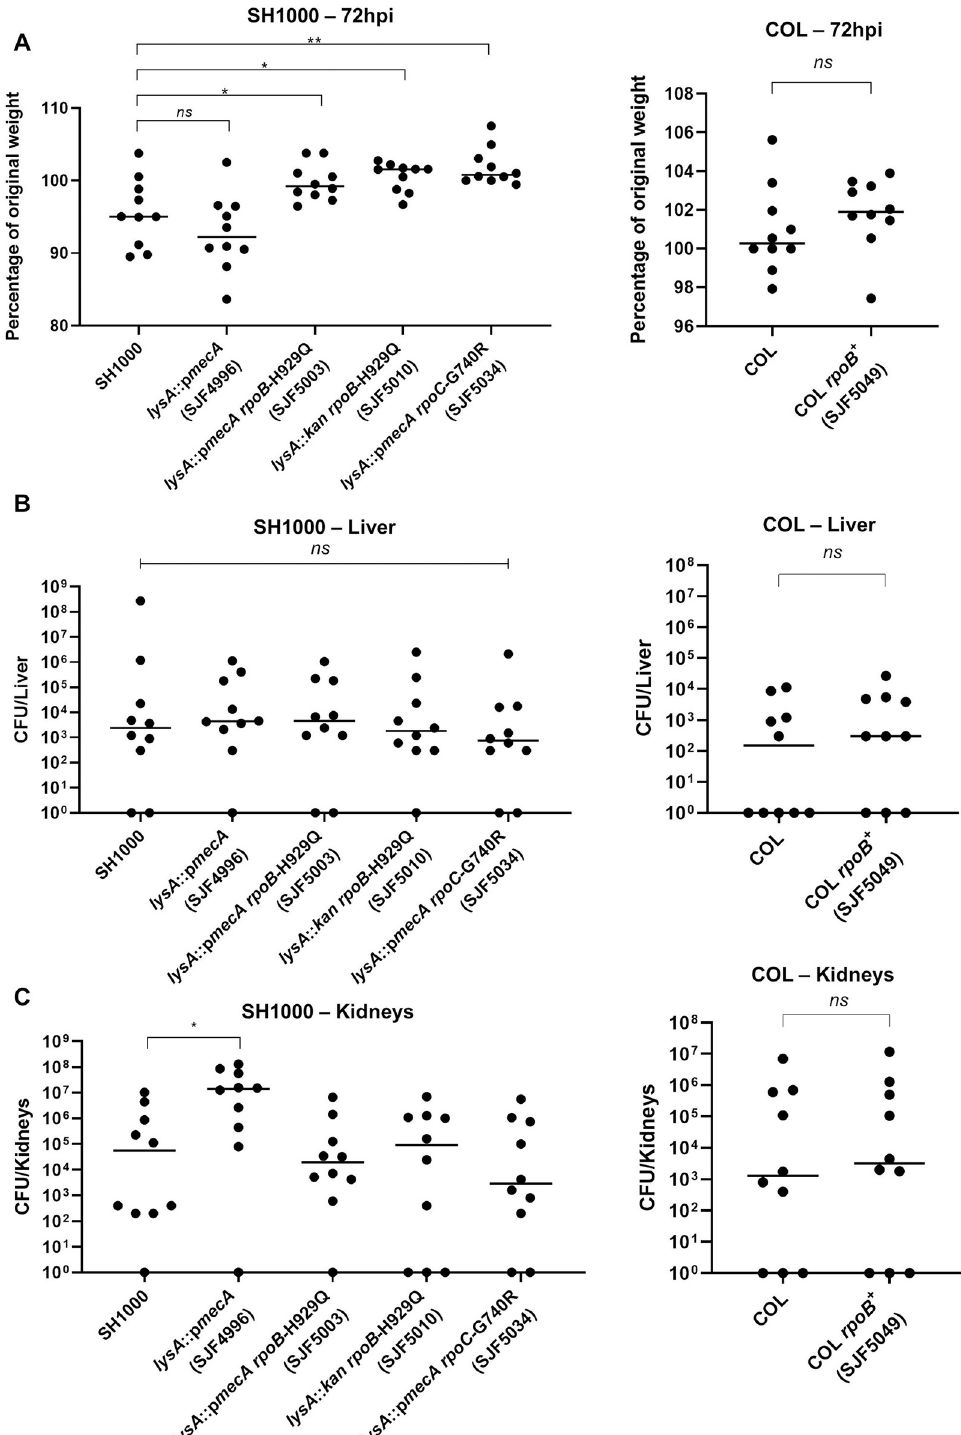
Fig 9. Virulence of S . aureus strains in a murine sepsis model. Mice were injected with 1 x 10 7 CFU per mouse with SH1000, lysA ::p mecA (SJF4996), lysA ::p mecA rpoB -H929Q (SJF5003), lysA :: kan rpoB -H929Q (SJF5010), lysA ::p mecA rpoC -G740R (SJF5034), COL, COL rpoB + (SJF5049) and animals ( n = 10 mice per group) were euthanised at 72 hpi. A) Weight analysis. Colony forming units (CFUs) per organ B) Kidneys and C) Livers were recovered from animals infected with strains listed above. Statistical significance determined by Mann-Whitney two-tailed test; ns , p > 0.05; � p < 0.05; �� p < 0.005. https://doi.org/10.1371/journal.ppat.1008672.g009 PLOS Pathogens| https://doi.org/10.1371/journal.ppat.1008672 July 24,